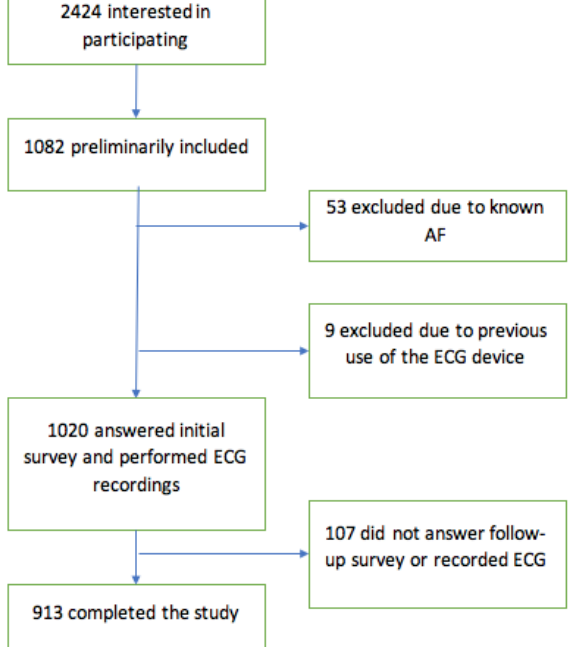
Figure 1. Flow chart for recruitment of the 2024 presumptive participants. AF: atrial fibrillation; ECG: electrocardiogram.